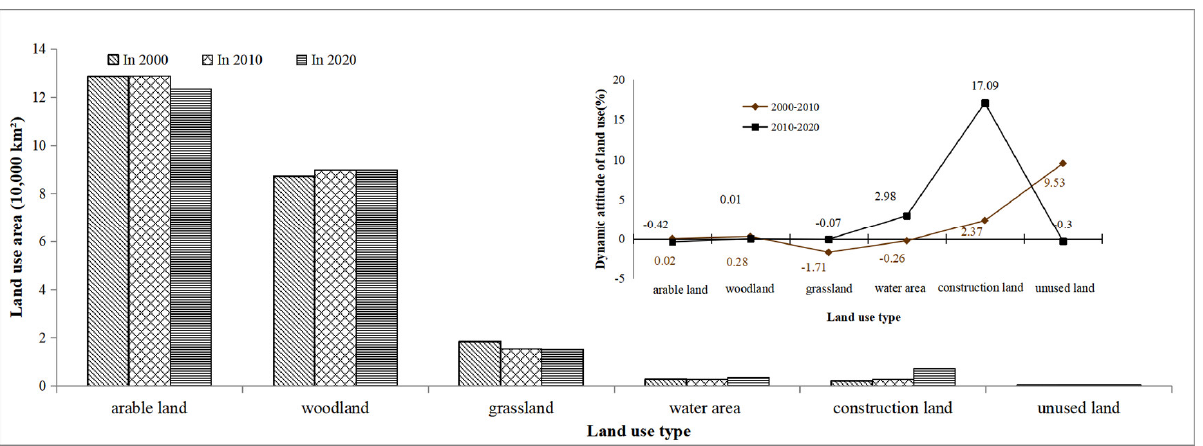
Figure 4. Landscape patterns showing the distributions of the land use types in 2000, 2010, and 2020.